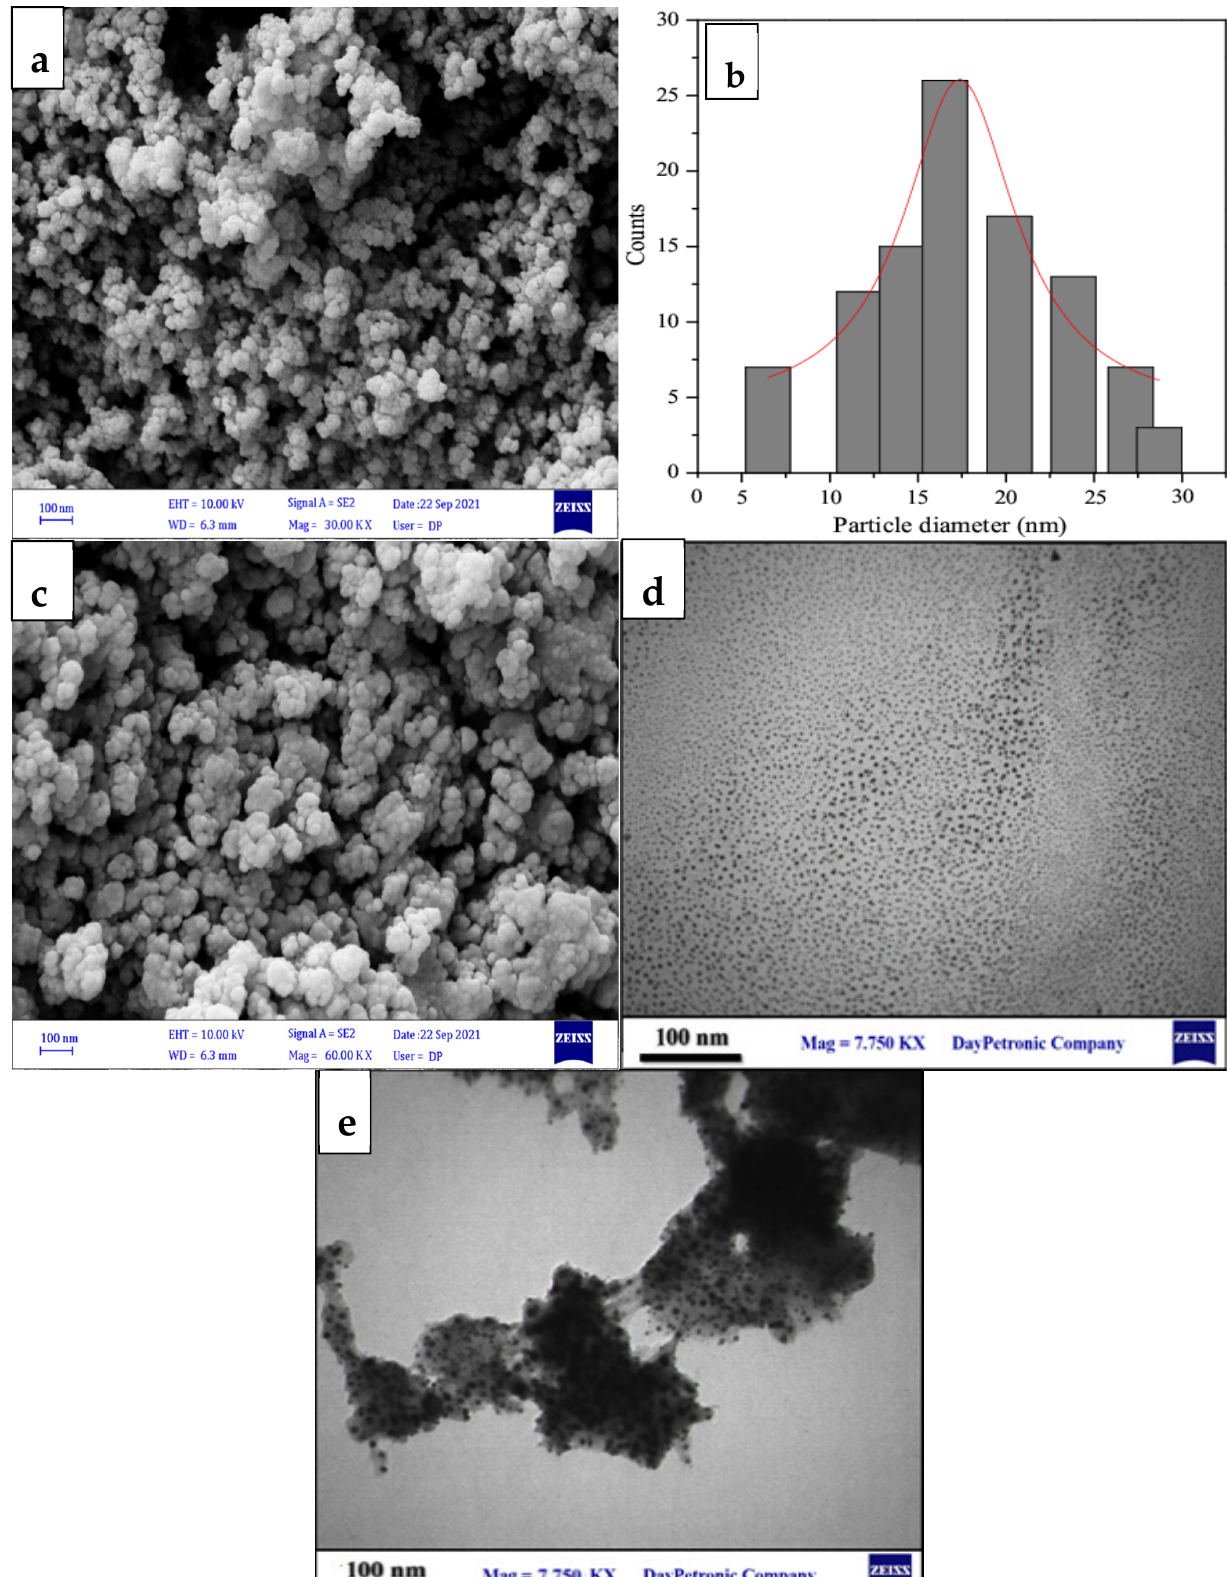
Figure 4. FESEM images of AgNPs@AG and size distribution( a,b ) and Ag − Hg ( c ); HR-TEM images of AgNPs@AG ( d ) and Ag − Hg ( e ).